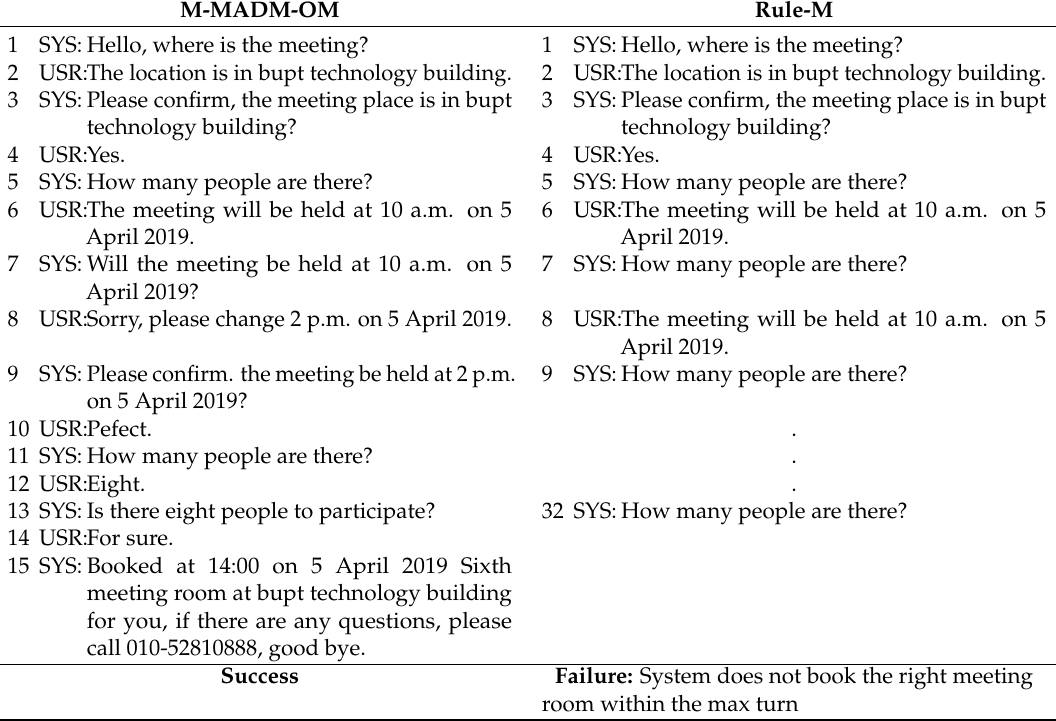
Table 3. Two sample dialogue sessions on human users comparing M-MADM-OM with